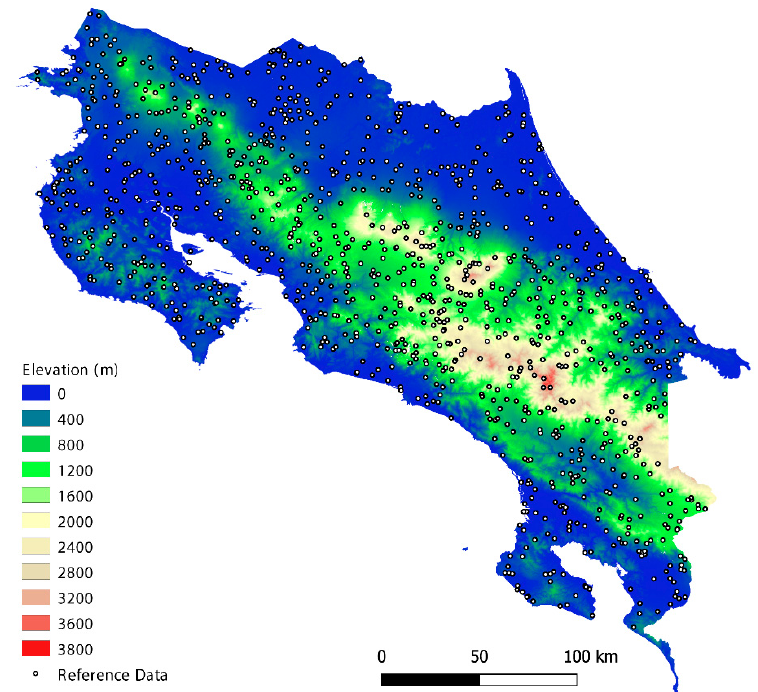
Figure A1. Elevation across Costa Rica, with locations of reference data shown. Note the central mountain range running northwest–southeast.